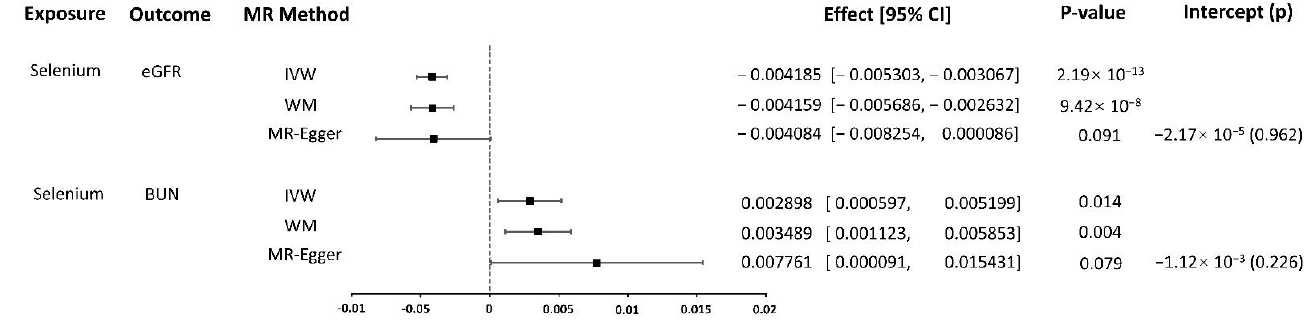
Figure 2. MR results.